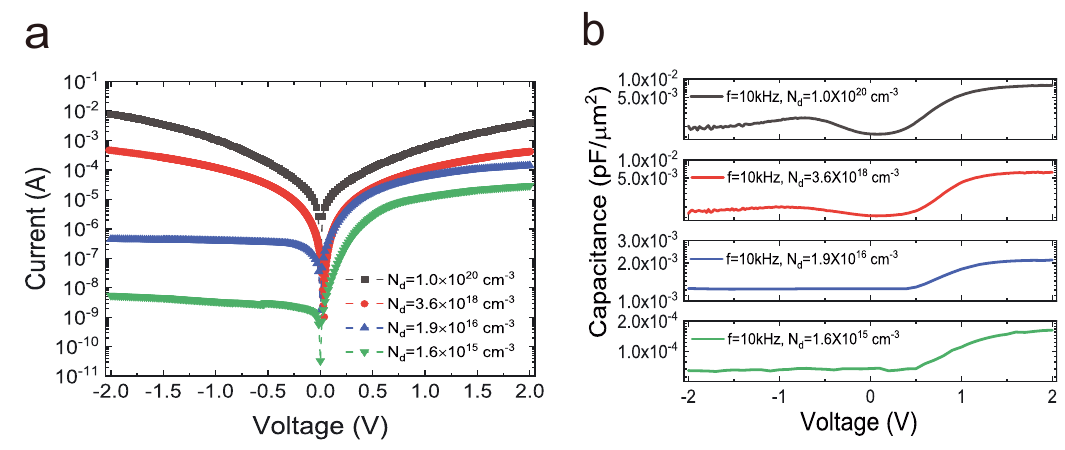
Figure 2: Electrical characteristics of MIS junctions in four doping levels in n-Si. (a) I – V curves of MIS junctions with the area of 5 × 5 μ m 2 , (b) C – V curves of MIS junctions with the area of 500 × 500 μ m 2 at a low frequency of 10